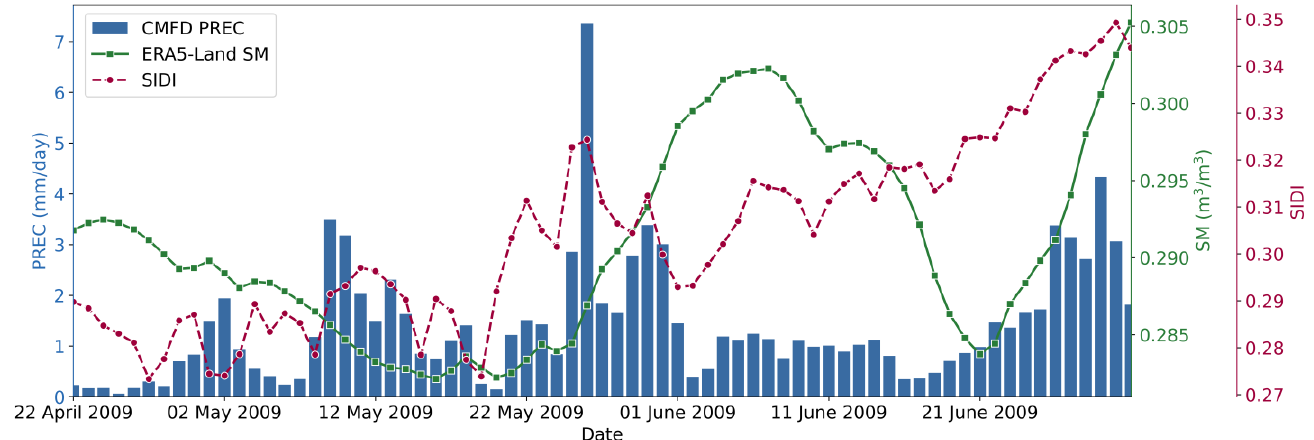
Figure 7. Temporal evolution characteristics of drought processes captured by SIDI in the Xizang Autonomous Region from 22 April to 01 July 2009, against ERA5-Land SM and CMFD PREC.